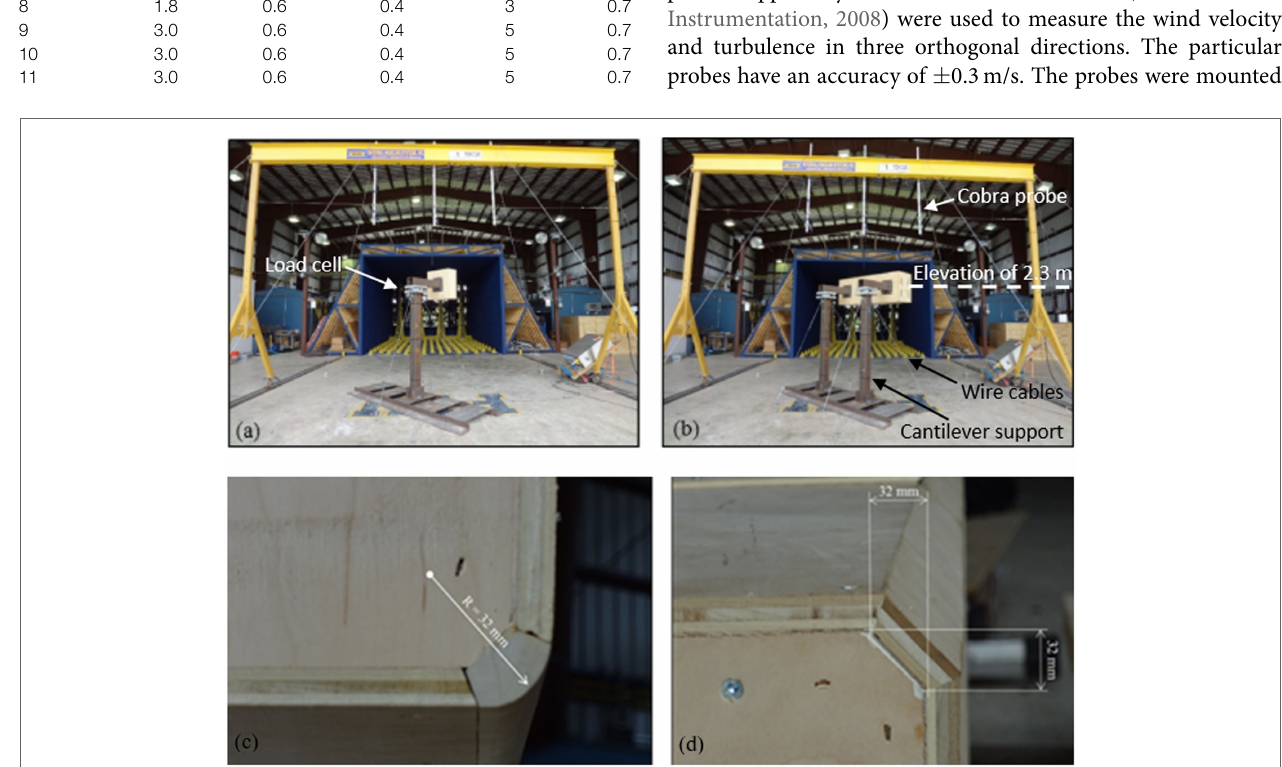
FIGURE 3 | Testing of variable message sign (VMS) models: (A) single support system; (B) double support system; (C) round corner (Model 10); (D) chamfered corner (Model 11).